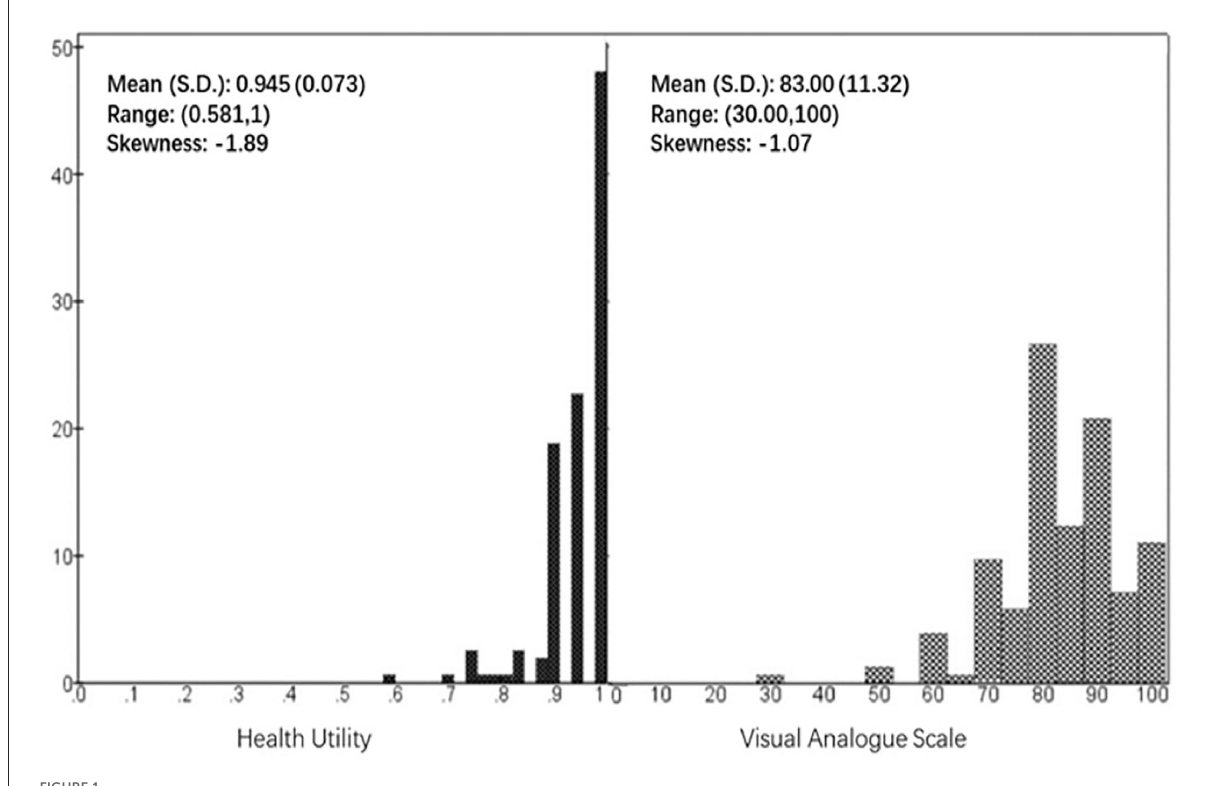
FIGURE1 Distribution of health utility and visual analog scale.